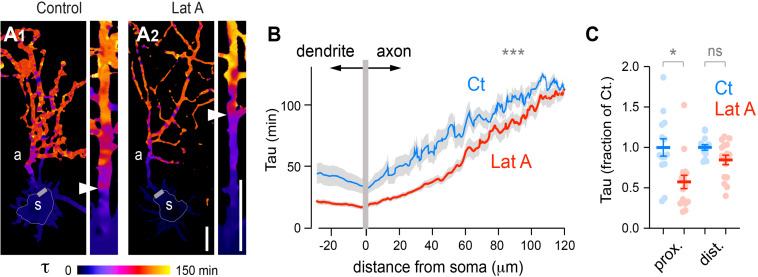
Disruption of F-actin accelerates the diffusion of cytoplasmic proteins throughout the entire neuron and is more pronounced in proximal than in distal axonal segments. (A) Tau heat maps of tdTom decay in DIV5 neurons treated with vehicle (Control) or 7.5 μM Latrunculine A for 60–120 min (Lat A). Scale bar 25 μm. Shown are whole cell tau maps and straightened axons at higher magnification. Simplified shape of somata and start of presumed axons are indicated by thin and thicker gray lines, respectively. Arrowheads in straightened axons mark the transition from fast to slower diffusion. (B) Tau variations along the main dendrite and axon as a function of distance from the soma in neurons treated with vehicle (Ct) or LatA. Shown are means ± SEM from N = 13–16 neurons; ***p < 0.001; Kolmogorow’s test. Note the lower tau values in cells treated with LatA. (C) Average Tau (fraction of control) in proximal (20–25 μm) and distal (100–105 μm) axonal segments. Shown are means ± SEM. N = 13–16 neurons; **p < 0.01; Kruskal–Wallis, Dunn’s multi-comparison tests. Note the more pronounced effect of LatA on proximal segments.